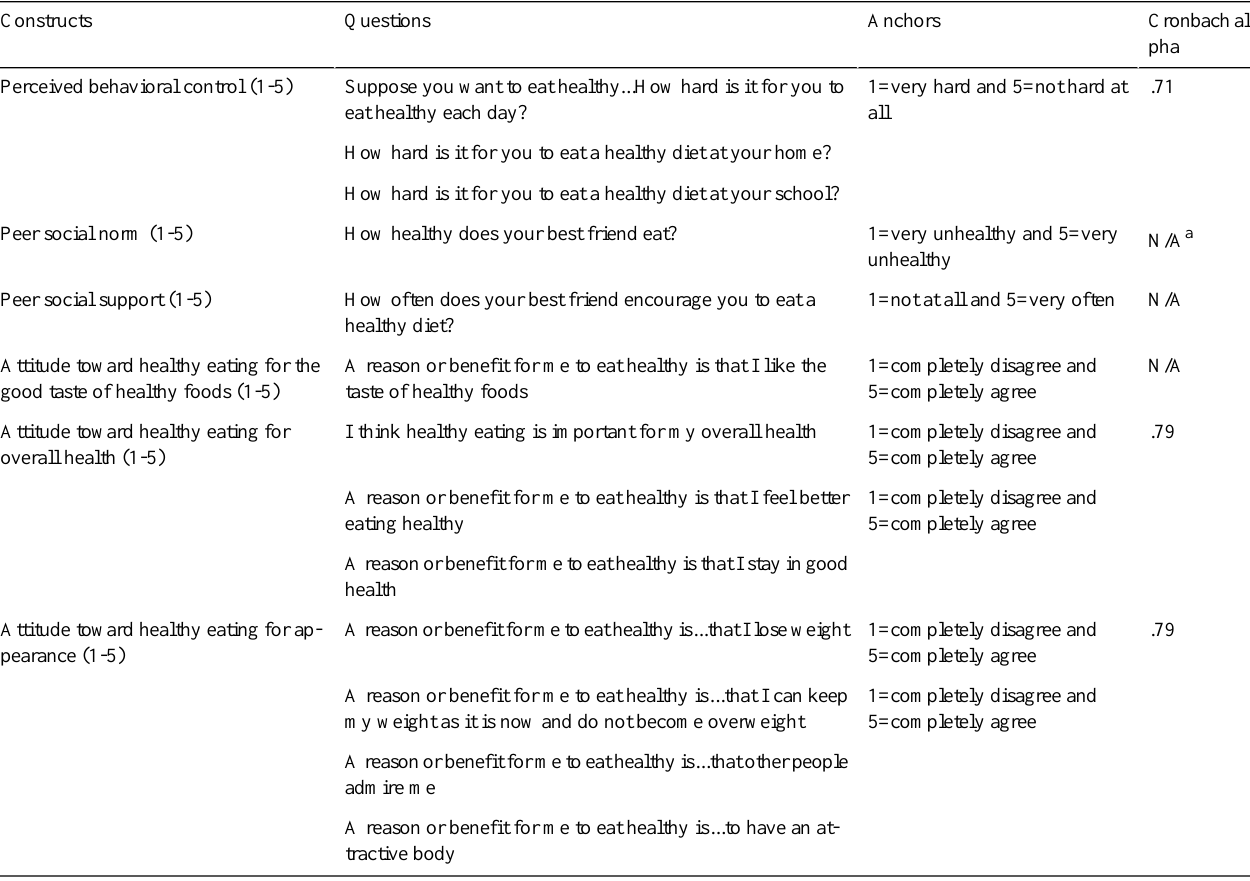
Table 1. Overview used constructs, items, and anchors of the healthy diet determinants questionnaire.